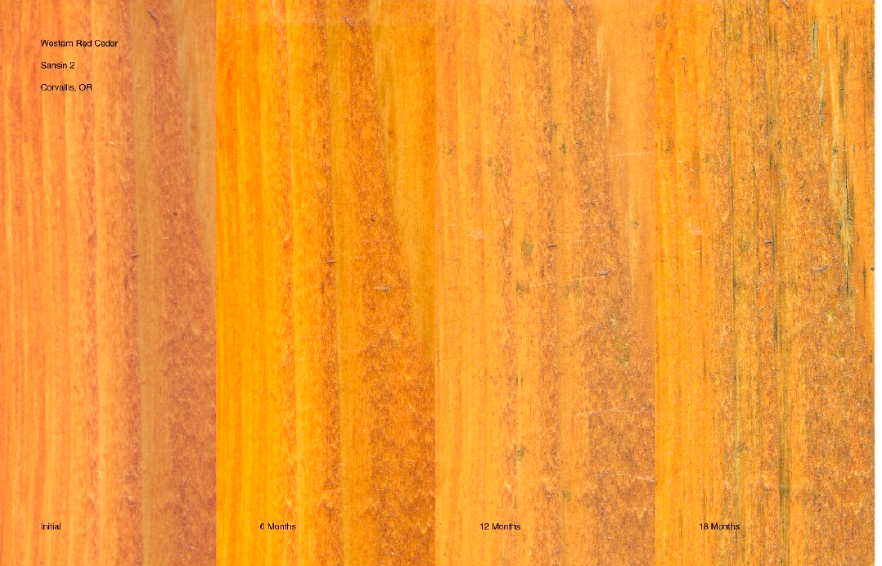
Figure 18. Example of the same western redcedar sample treated with Sansin 2 and exposed on a test fence near Corvallis, OR for 0, 6, 12, and 18 months (left to right).